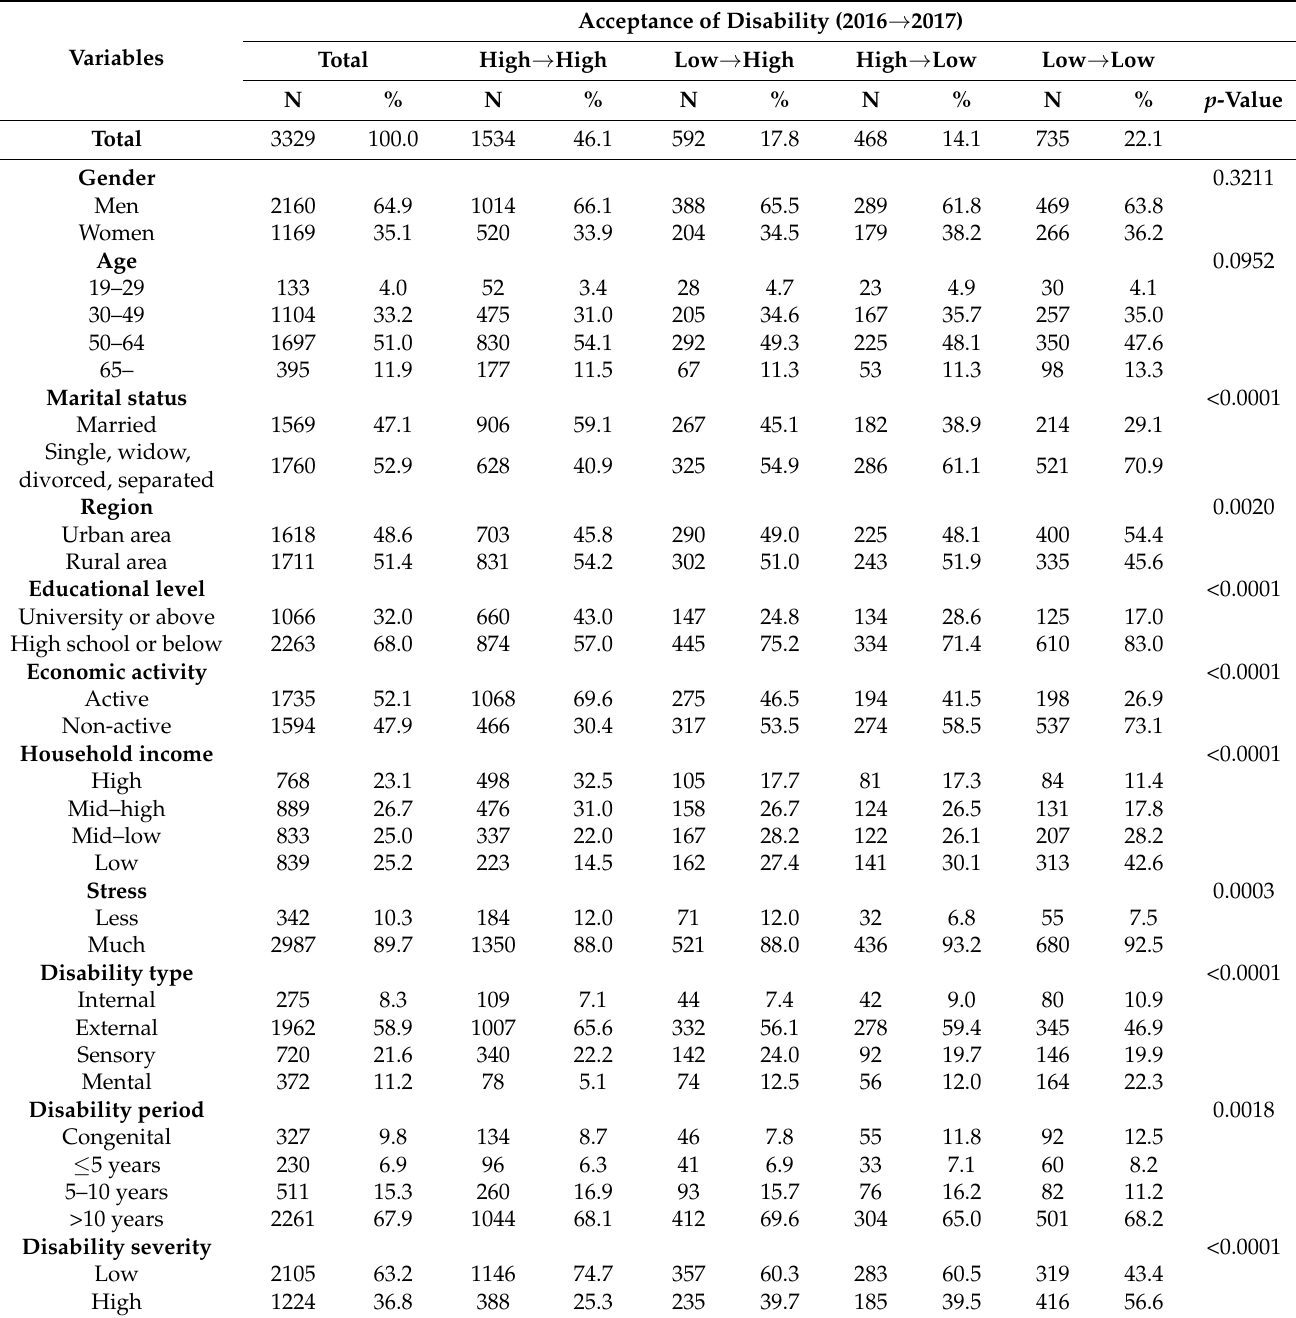
Table 1. Baseline characteristics of the study population (baseline,